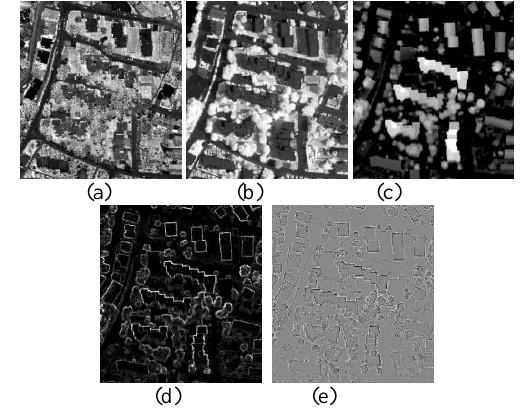
Figure 6: The produced features of Area1, (a) Intensity image of